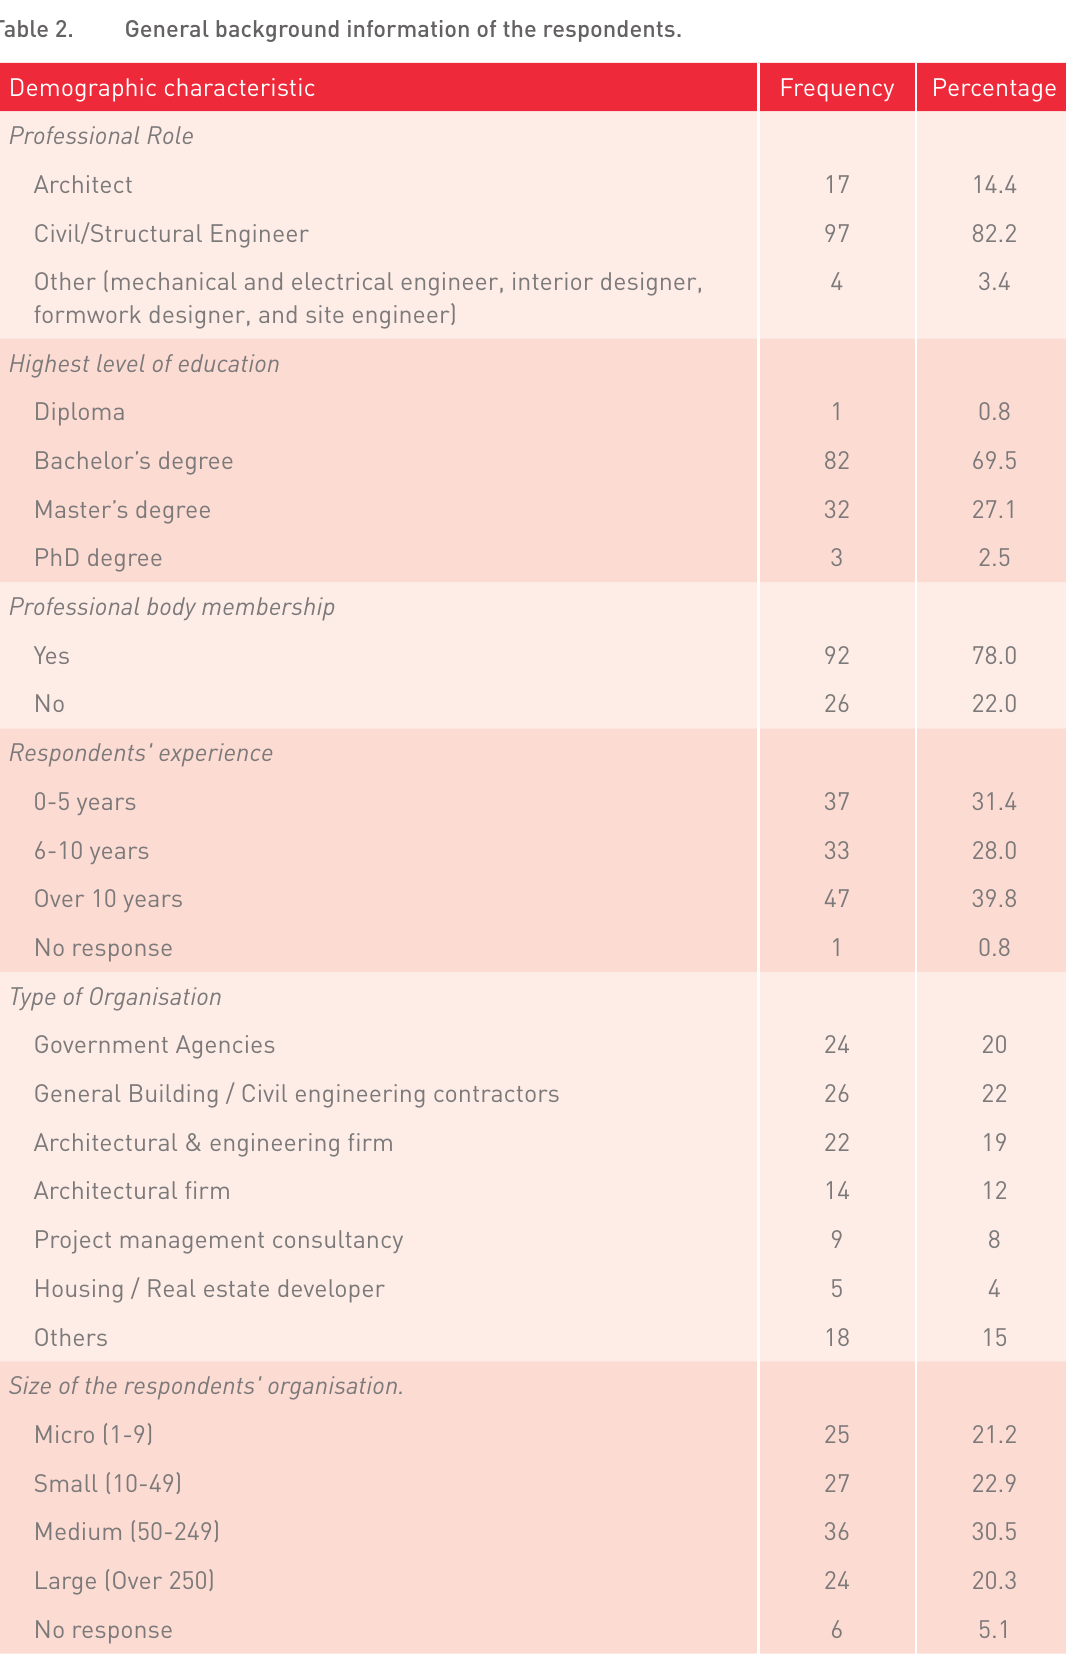
Table 2. General background information of the